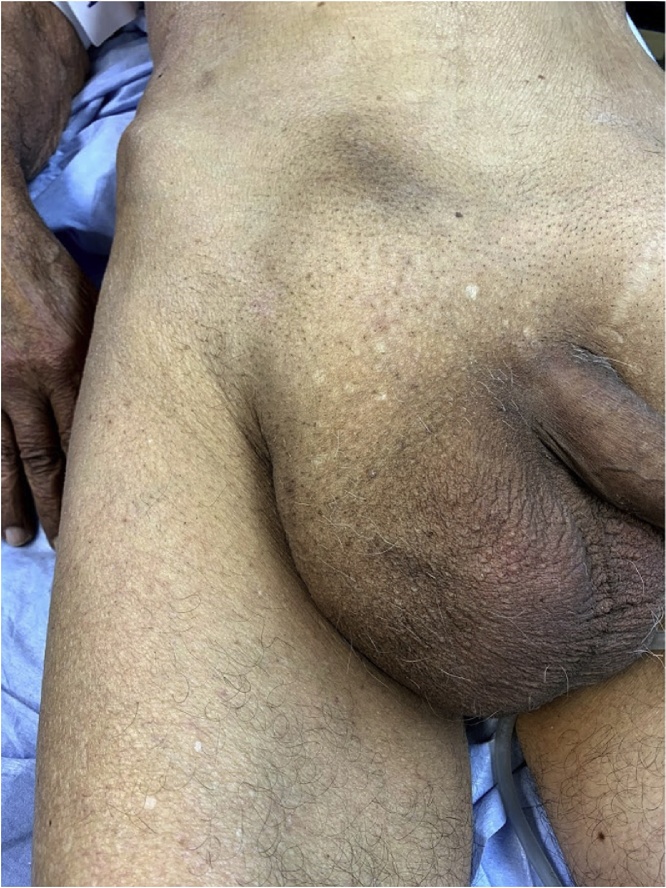
Clinical finding.